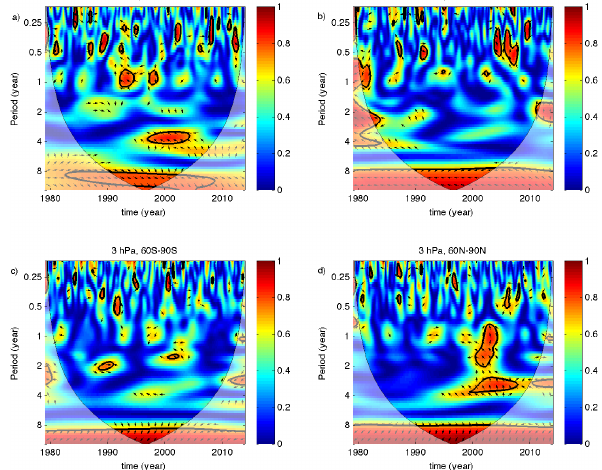
3 and Mg II index for selected vertical pressure levels and latitude bands: (a) 30hPa, 30 ◦ S–30 ◦ N; (b) 1hPa, 30 ◦ S–30 ◦ N; (c) 3hPa, 60 ◦ S– 90 ◦ S; (d) 3hPa, 60 ◦ N–90 ◦ N. Thick contours identify the 5% sig- nificance level against red noise, while arrows denote the phase be- tween the two signals (in phase pointing eastward and out of phase pointing westward). The cone of influence (COI) where edge effects might distort the picture is shown as a lighter